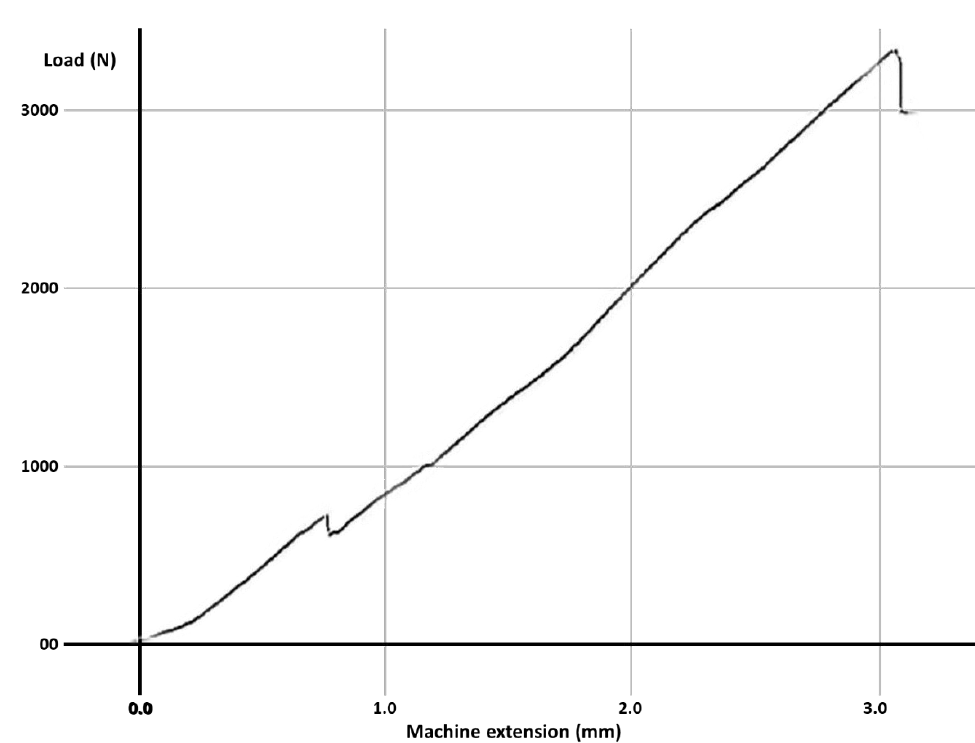
Figure 6. The maximum value of the force at which the most resistant molar from Group E failed.